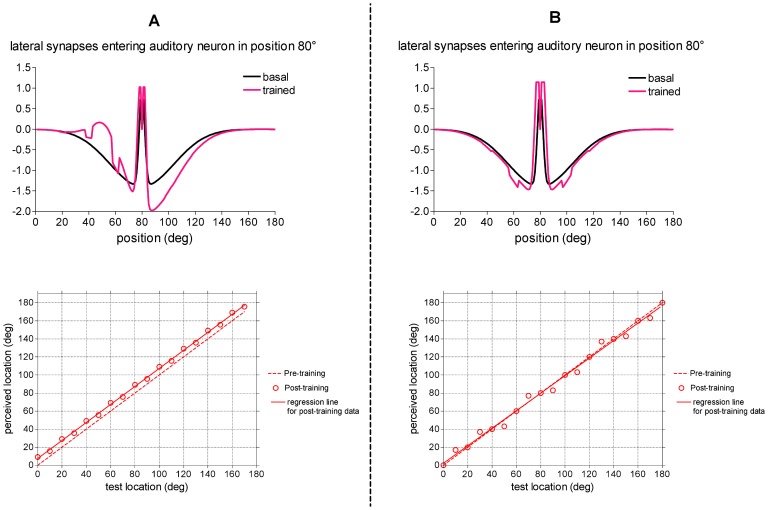

Results of training paradigm 2.(A) Case 2.a: training with spatially disparate stimuli in variable position with fixed audio-visual spatial disparity (20°) The auditory stimulus could be located in one among nine positions (from 20° to 180° with 20° step), and the simultaneous visual stimulus was located in fixed spatial relationship (pv = pa+20°). The overall training procedure consists of ten trials; in each trail, the nine positions were trained once (for 200 ms, each) in a random order. Upper panel: Lateral synapses entering an exemplary auditory neuron (neuron in position 80°, one of the trained position) are shown before and at the end of the overall training procedure. Lower panel: Behavior of the trained network in response to auditory unimodal stimulation. The test auditory stimulus had strength  = 15, and was applied at different positions. The perceived sound location, computed in steady-state condition, was reported as a function of the original location of the test stimulus (values represented by circles). For comparison, the behavior of the untrained network was shown too (dashed line). The regression line for the post-training data (continuous line) has slope 1 and offset ∼7.5° (r2 = 0.9990, p<0.0001). (B) Case 2.b: training with spatially coincident stimuli in variable position. The auditory stimulus could be located in one among nine positions (from 20° to 180° with 20° step), and the simultaneous visual stimulus was located in the same spatial position (pv = pa). The overall training procedure was the same as panel A (but with spatially coincident stimuli). Upper panel: Lateral synapses entering an exemplary auditory neuron (neuron in position 80°, one of the trained position) are shown before and after the training. Lower panel: Behavior of the trained network in response to auditory unimodal stimulation. The same auditory unimodal test as in panel A was performed. In this case, the regression line for the post-training data is almost indistinguishable from the pre-training line.